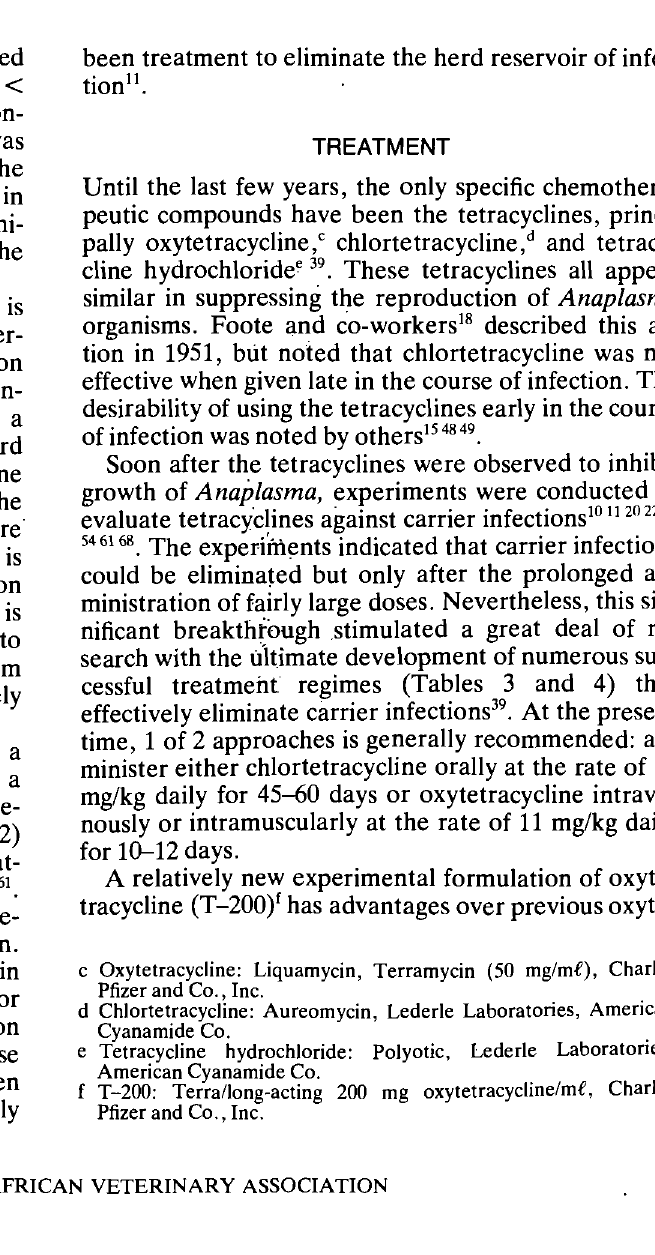
Table 2: SEROLOGIC RESULTS ON 361 ANIMALS FROM A SINGLE HERD WITH THE COMPLEMENT-FIXATION (CF) AND THE RAPID (PLASMA) CARD AGGLUTINATION (CT)